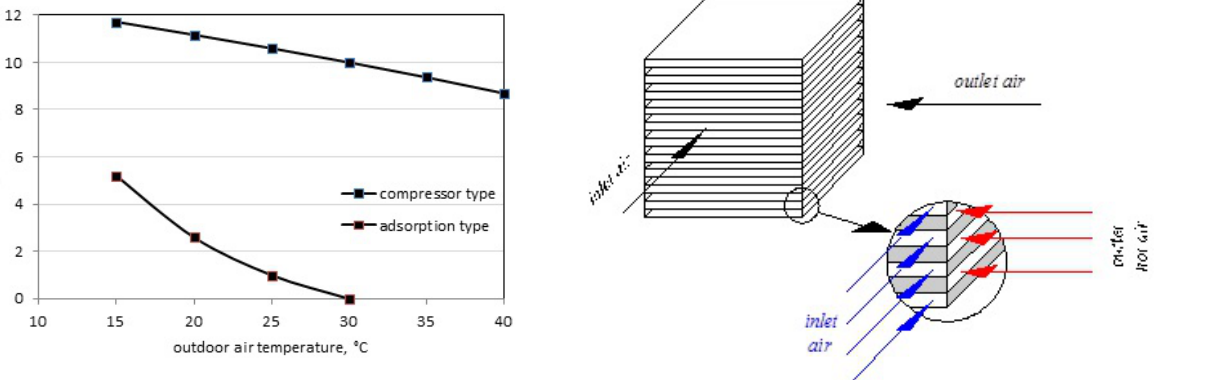
Figure 14: Cassette-type heat